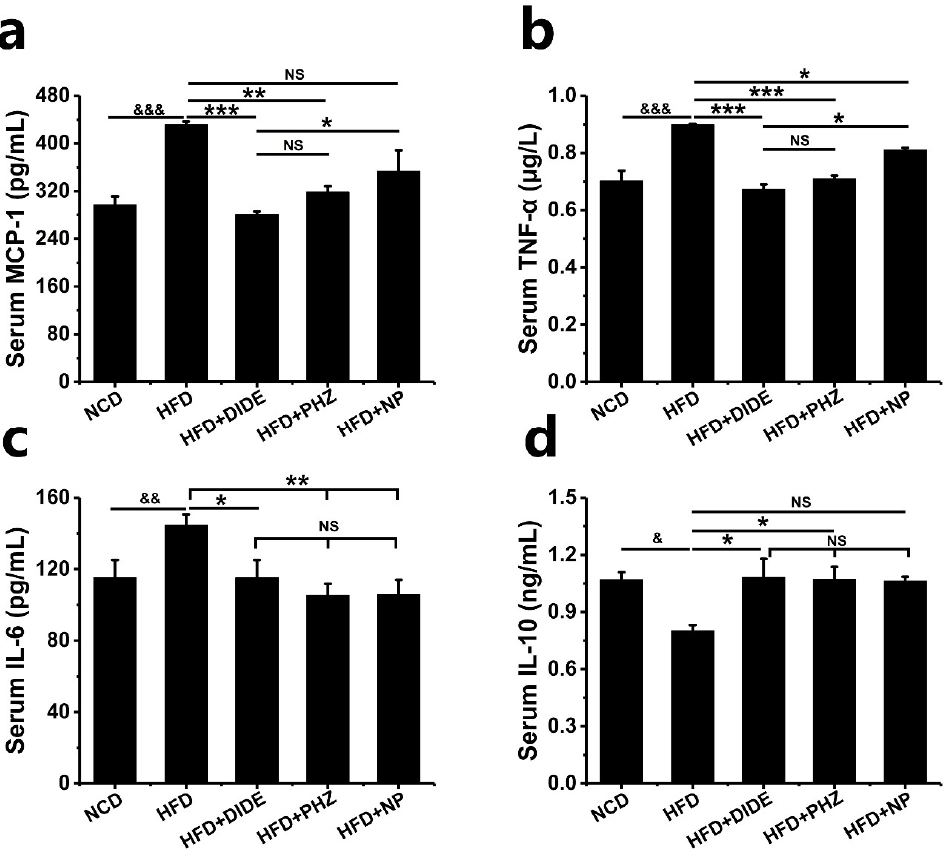
Figure 5. Effects of DIDE, PHZ and NP administration on serum inflammation (n = 10 per group). ( a )